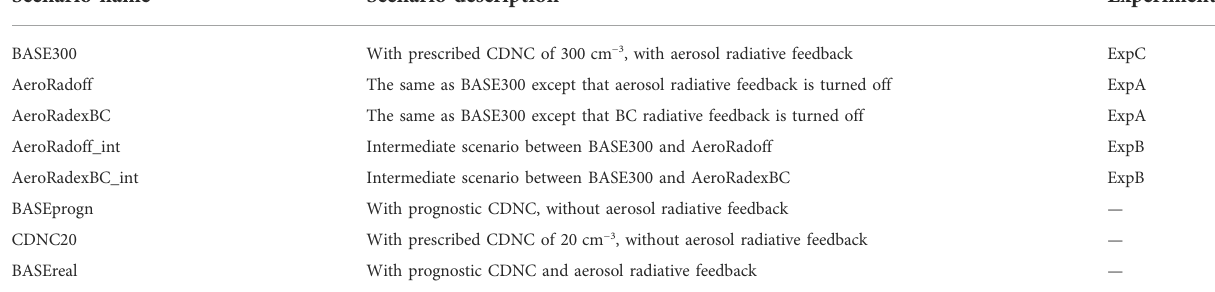
TABLE 1 Scenarios for modeling aerosol effects, and their corresponding experiment in the framework of isolating aerosol direct and semi-direct effect illustrated in Figure 2. The fi rst fi ve scenarios, including BASE300, AeroRadoff, AeroRadexBC, AeroRadoff_int, and AeroRadexBC_int, are designed to evaluate the direct and semi-direct effect. BASEprogn and CDNC20 scenarios are designed to evaluate the indirect effect. Total aerosol effect is calculated based on the difference between BASEreal and CDNC20 scenarios. Scenario